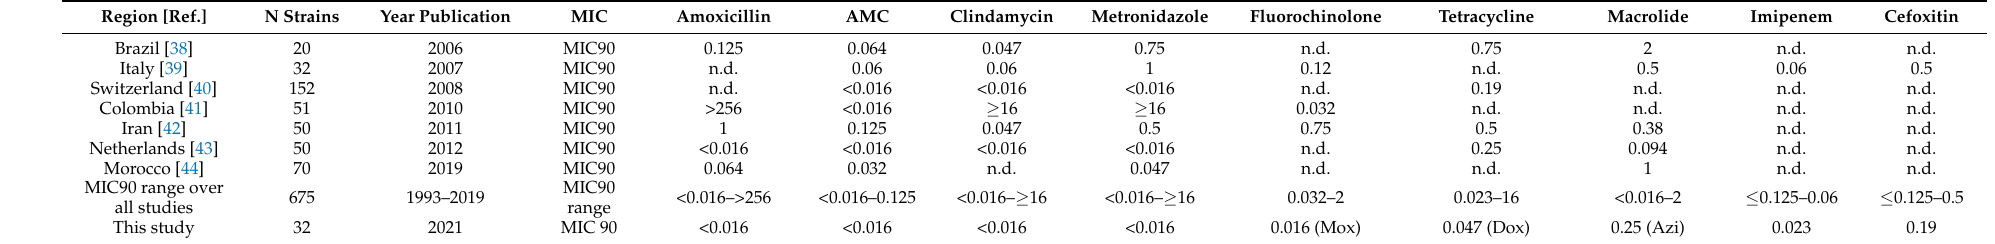
Table 3. Cont. Region